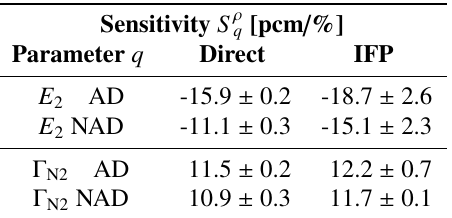
Table 3. Sensitivity to the second 16 O resonance parameters on the PST001